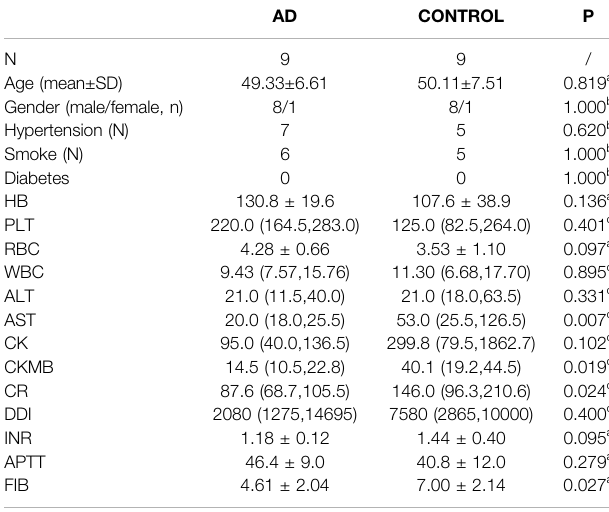
TABLE 3 | Clinical features of Western blot, immuno fl uorescence analysis